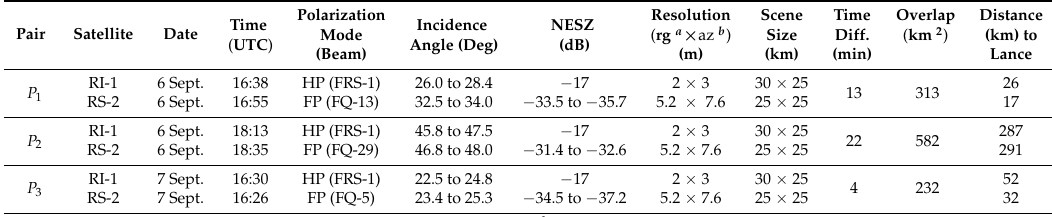
Table 1. Properties of the overlapping RISAT-1 (RI-1) [16] and Radarsat-2 (RS-2) scenes [17]. Both sensors transmit waves with frequency in the C-band